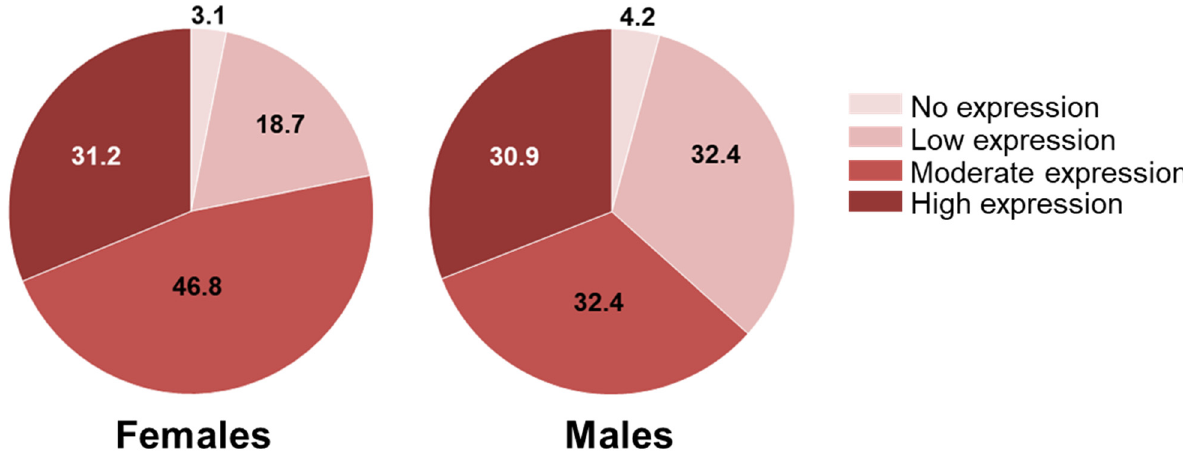
Figure 8. SSTR3 expression in human NFPTs. A cohort of 107 NFPT patients was previously characterized for the expression of SSTRs, including SSTR3. Utilizing the published semi-quantitative expression scoring method, tumors were divided into four categories of protein expression, as indicated. The distribution of the tumors having these scores between males and females is indicated in the percentage of the total cases.